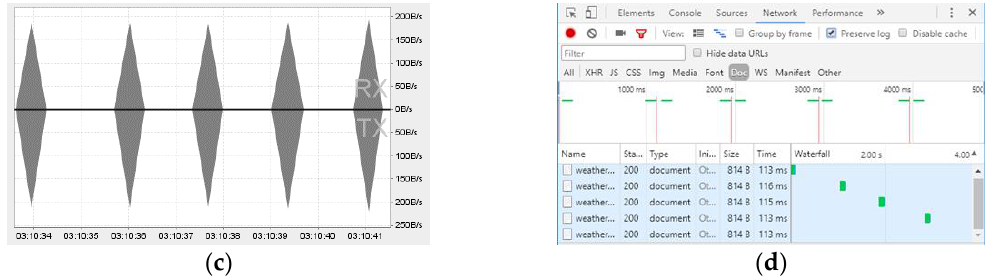
Figure 16. Network monitoring for accessing services. ( a ) Interaction A; ( b ) Interaction B; ( c ) Interaction C; ( d ) Interaction D.